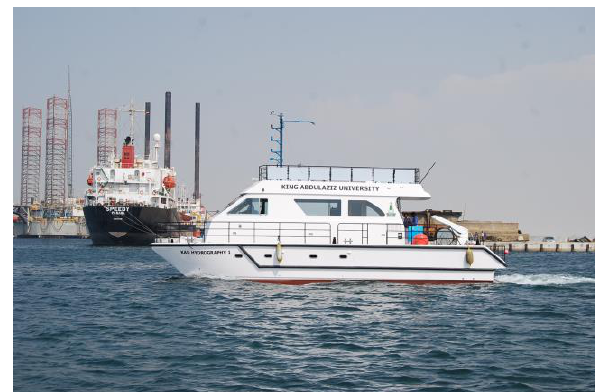
Figure 1. KAU Hydrography 1 Vessel